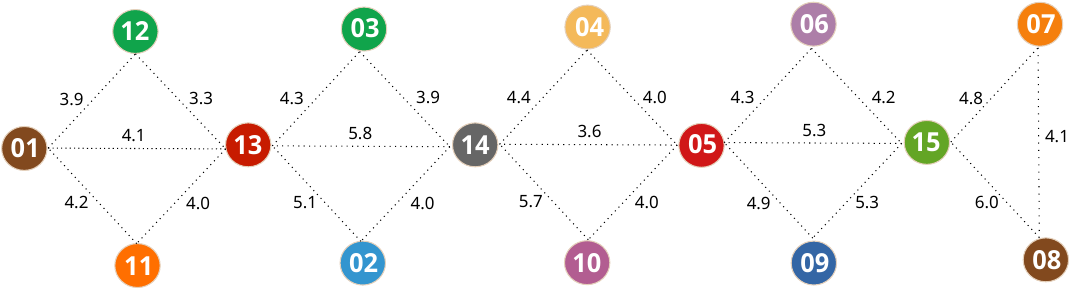
Figure 8. Path loss exponents among anchors computed from a real-world experiment. The lines are just a small subset of the connectivity among anchors and does not represent the full